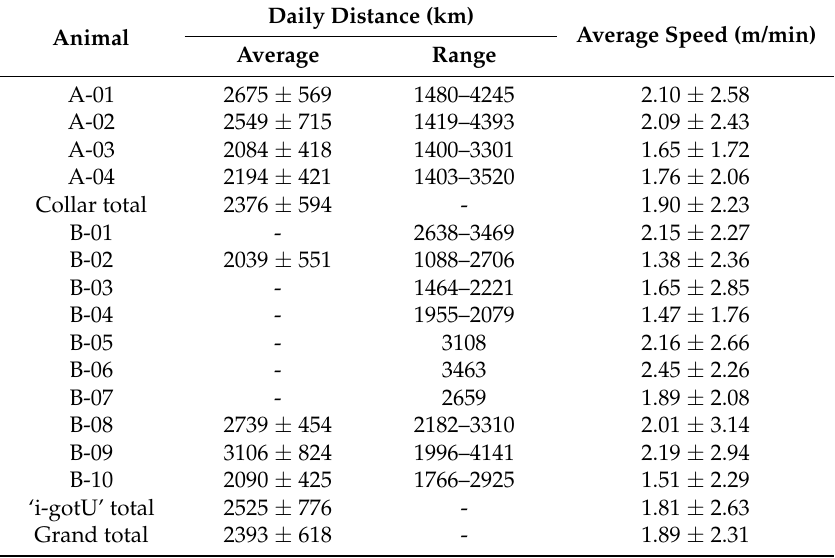
Table 2. The distance moved per day (average and range) and the average speed (including standard deviation) between location fixes for eastern grey kangaroos at Heritage Park, Coffs Harbor, New South Wales, Australia. Animals designated as ‘A’ were fitted with GPS collars while animals designated as ‘B’ were fitted with ‘i-gotU’ glue-on